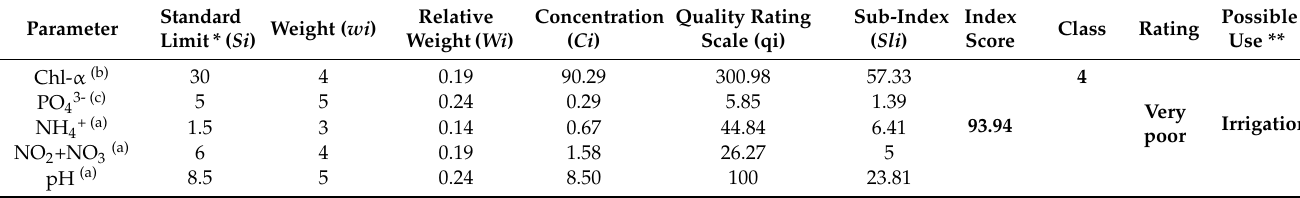
Table 6. Calculated water quality index for the Roodeplaat